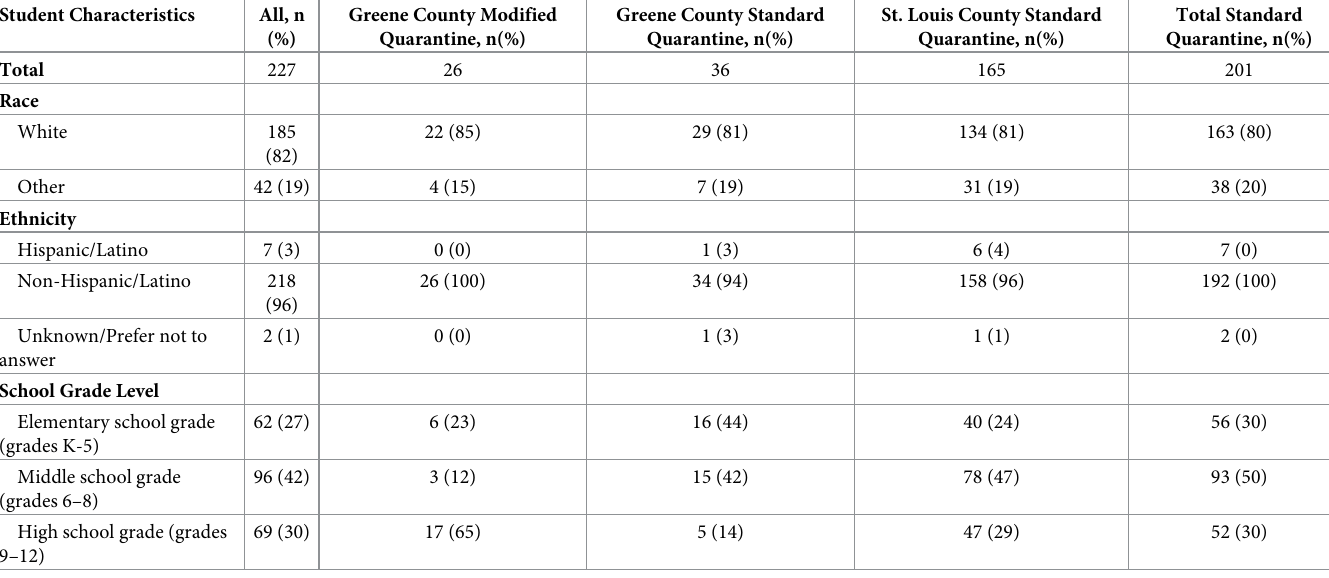
Table 2. Demographic characteristics of students in close contact with persons who tested positive for SARS-CoV-2. Student